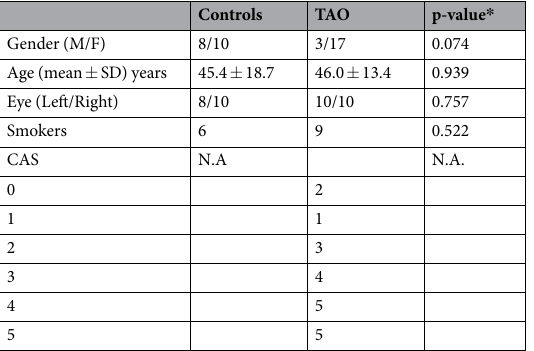
Table 1. Demographic description of the study cohort. The number of TAO patients showing a clinical activity score (CAS) from 0 to 5 are indicated. N.A: Not Applicable; M: male/F: female; SD: Standard deviation; CAS: Clinical Activity Score; * Fischer tests for categorical variables and Mann-Whitney U tests for continuous